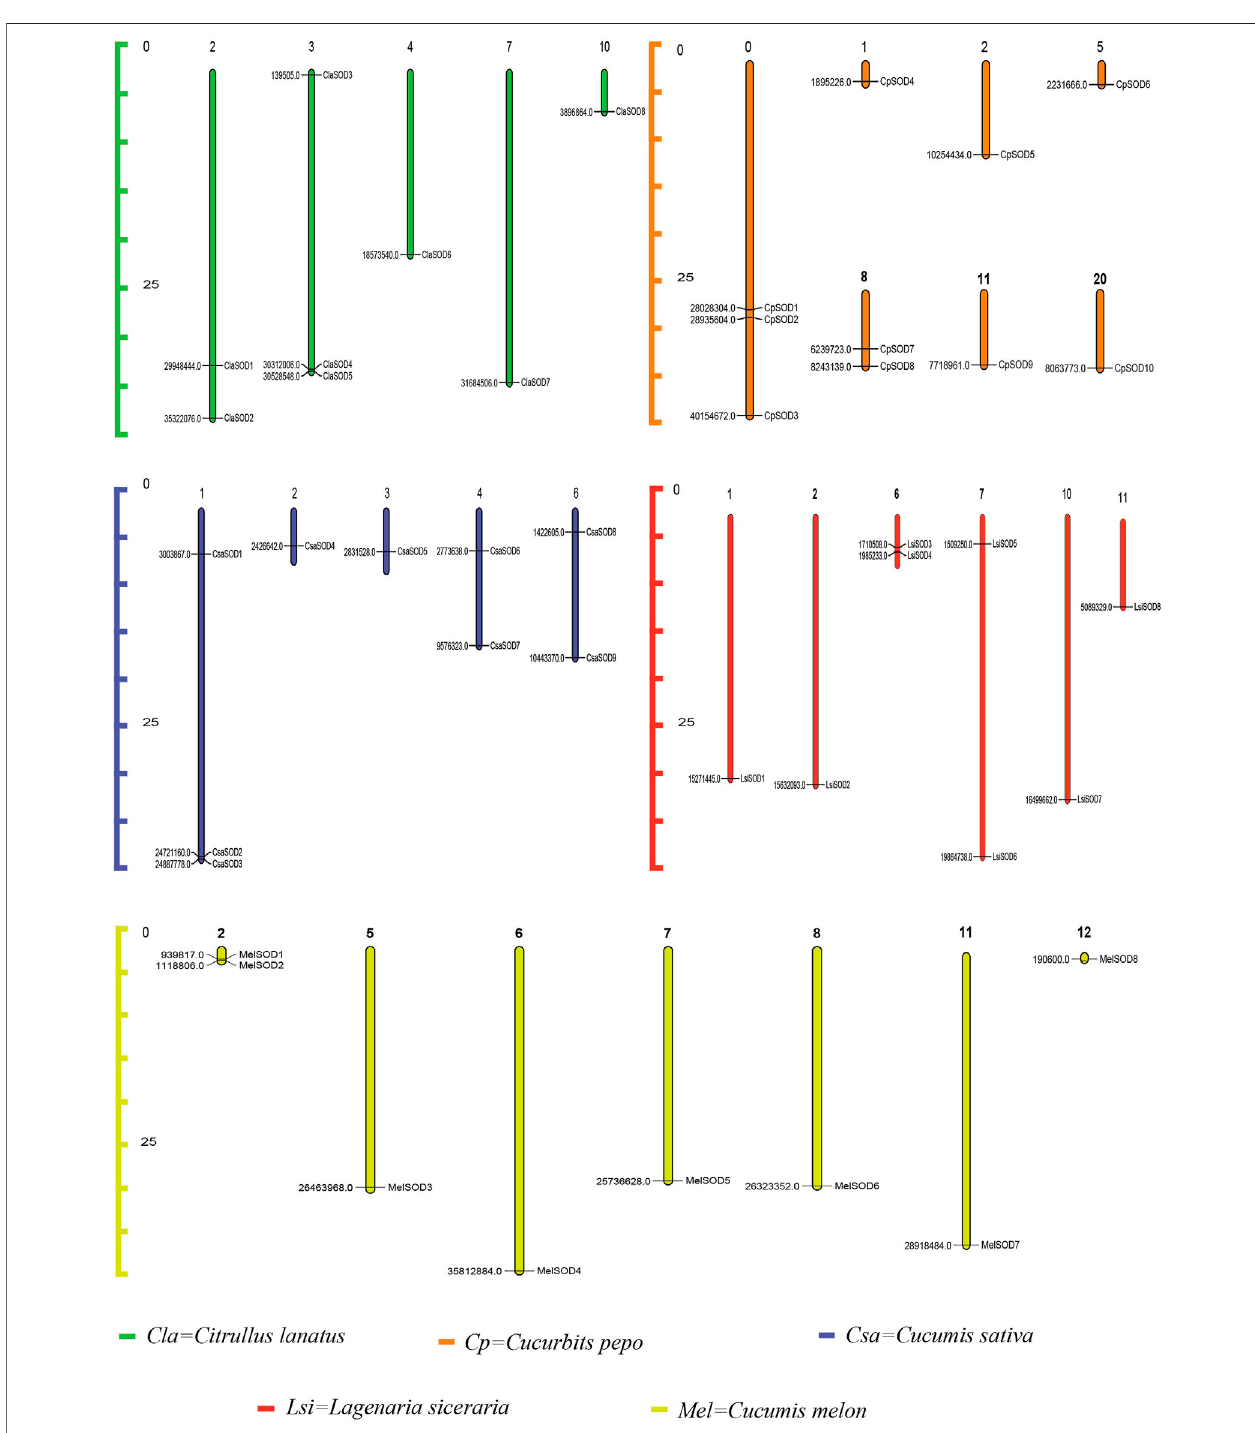
FIGURE 3 | Chromosomal locations of 43 SOD genes in the genome of fi ve species of the Cucurbitaceae family. Watermelon: Cla; melon: Mel; cucumber: Csa; zucchini:Cp;bottlegourd:Lsi.Thechromosomenumbersareindicatedatthetopofchromosomes,andthesizeofthechromosomeisrepresentedwithaverticalscale. The gene number is located on each chromosome and the left scale is in megabases (Mb).